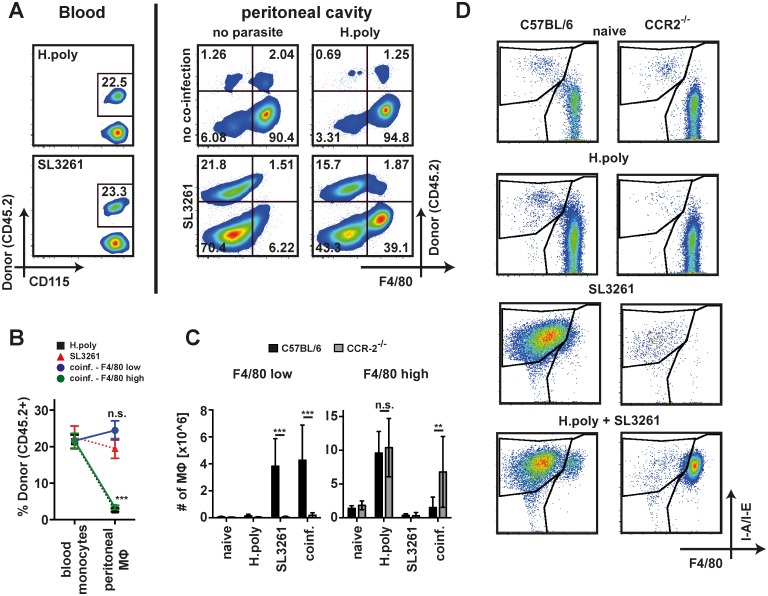
Bacterial co-infection leads to recruitment of MΦ from the vasculature.(A) Representative flow diagrams depicting CD45.2 chimerism in Ly6Chigh blood monocytes (CD11b+ CD115+ Ly6Chigh) or peritoneal MΦ (lineage- CD11c- F4/80+MHC+) in Cd45.1 host mice after partially shielded γ-irradiation, and subsequent single (top right, bottom left) or co-infection (bottom right). (B) Quantitative analysis of chimerism in Ly6Chigh blood monocytes and F4/80high (green circles) or F4/80low (blue circles) MΦ in co-infected mice analysed in E. As comparison chimerism of total MΦ in single H. polygyrus (filled squares) or SL3261 (red triangles) infected animals is shown. Data pooled from two separate experiments with 5 animals per group each. Asterisks indicate statistical differences between blood monocytes and peritoneal MΦ in co-infected animals. (C) Number of F4/80high and F4/80low peritoneal MΦ in SL3261 (SL3261), H. polygyrus (H.poly) co-infected (coinf.) or naive C57BL/6 (black bars) or Ccr2-/- mice (grey bars). Data pooled from two independent experiments with 4–6 mice per group. (D) Representative dot plots depicting MΦ isolated in C. **: p<0.01, ***; p<0.001; n.s.: not significant.